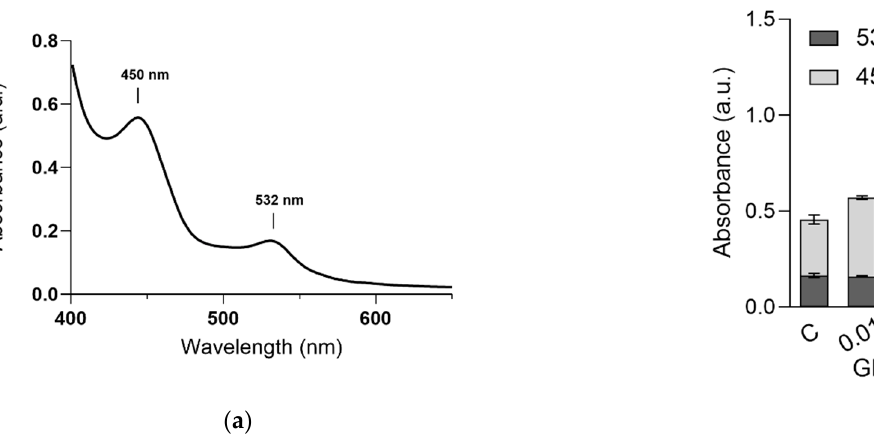
Figure 5. Characteristic UV-Vis spectra of the compounds resulted from the MDA assay ( a ) and the evolution of the absorbances of the 450 and 532 nm peaks with the increase in the Gd exposure ( b ).